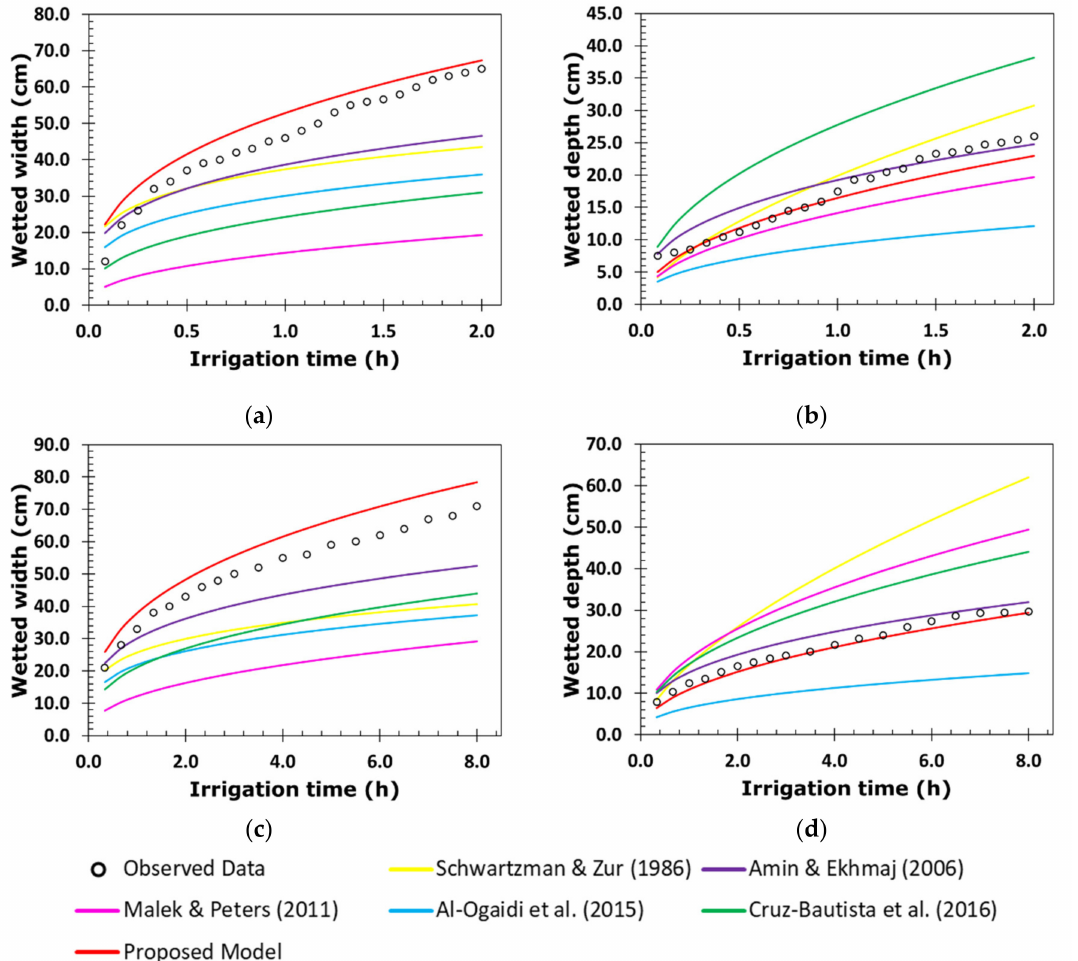
Figure 7. Temporal evolution of the width and depth of the wetting front of ( a , b ) irrigation 3A (q = 3.75 L h − 1 and θ i = 0.24 cm 3 cm − 3 ) and ( c , d ) irrigation 4A (q = 1.44 L h − 1 and